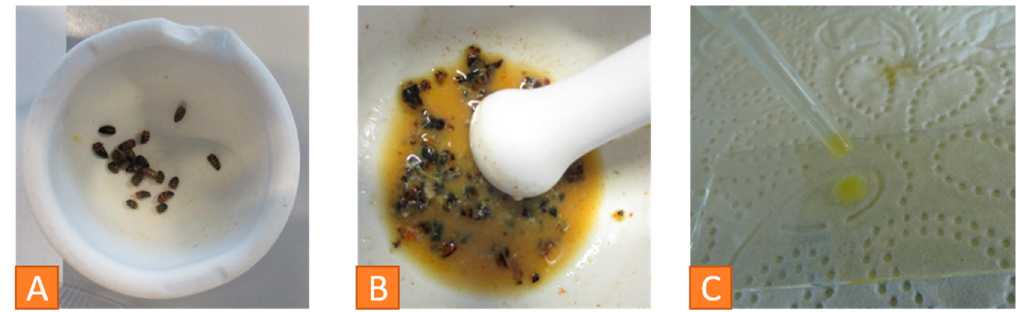
Figure 11. Detection of Nosemosis: ( A ) abdomens of 20 honeybees in a mortar, ( B ) crushing the abdomens with aqua purificata, ( C ) drop of the sample on a microscopic slide. © Julia Dittes. Nosema spores are oval-shaped and about 4 to 7 µm in length and 2 to 4 µm in width. The two